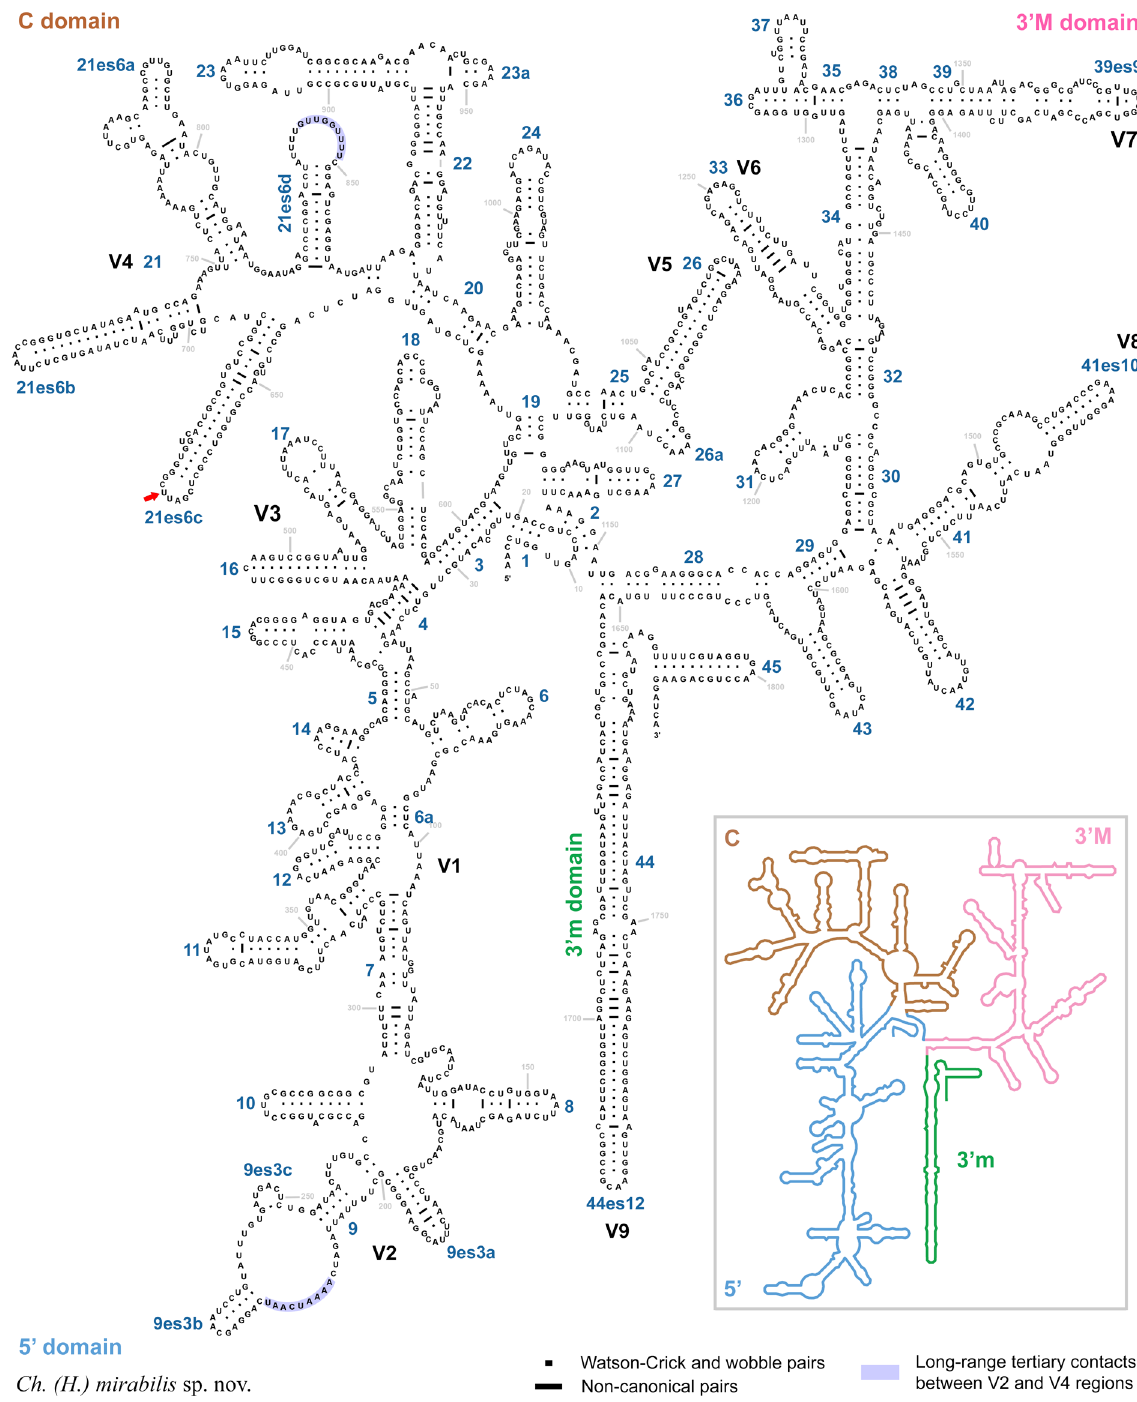
Fig. 5. Secondary structure of the 18S rRNA molecule of Chaetonotus ( Hystricochaetonotus ) mirabilis sp. nov. The single diagnostic molecular autapomorphy (red arrow) is situated in the terminal loop of helix 21es6c in the V4 region of the C domain. Note the long-range tertiary contacts between the V2 and V4 regions (highlighted in pink). The reference 18S secondary structure map of Saccharomyces cerevisiae Meyen ex E.C.Hansen (inset) is from http://apollo.chemistry.gatech.edu/RibosomeGallery (Petrov et al.